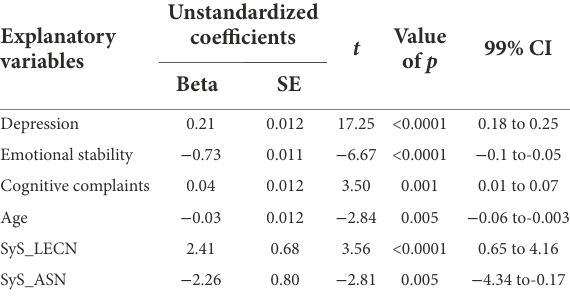
TABLE 2 Multiple linear regression analysis with retained explanatory variables, being RNT the predicted